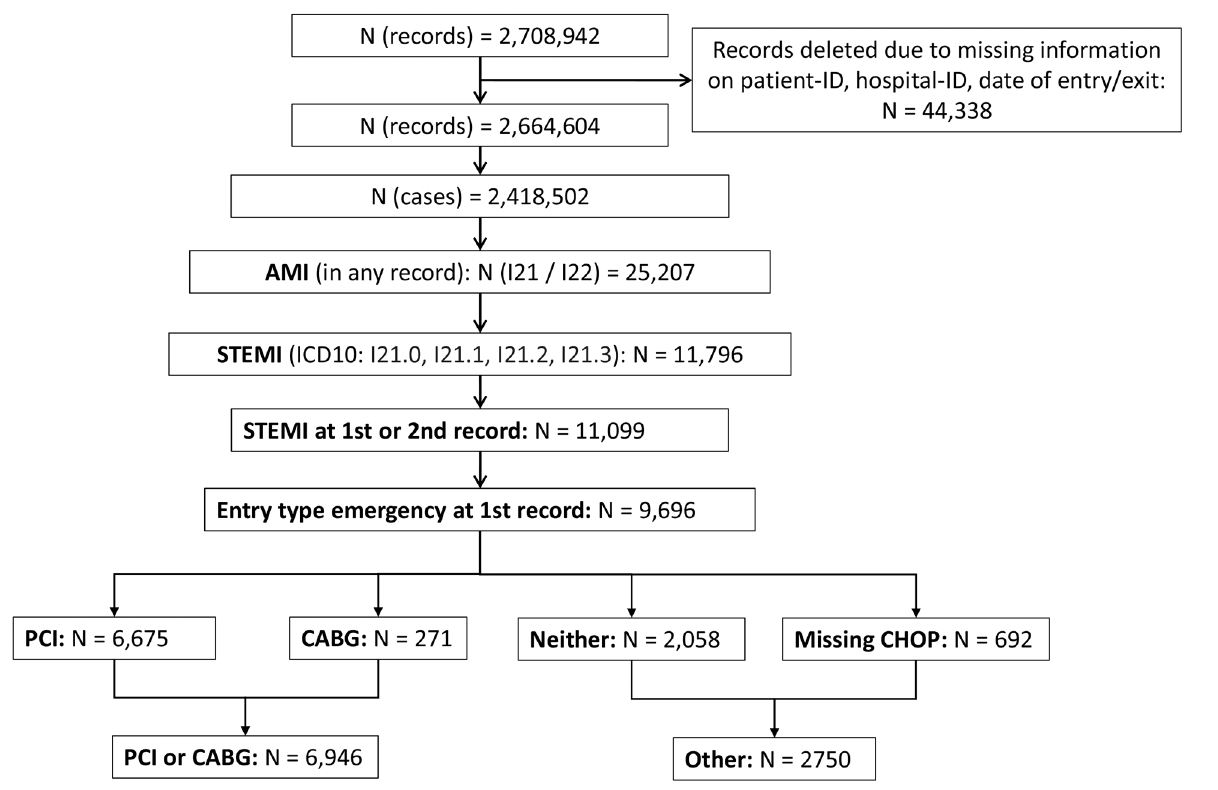
Fig 1. Flow chart of the selection